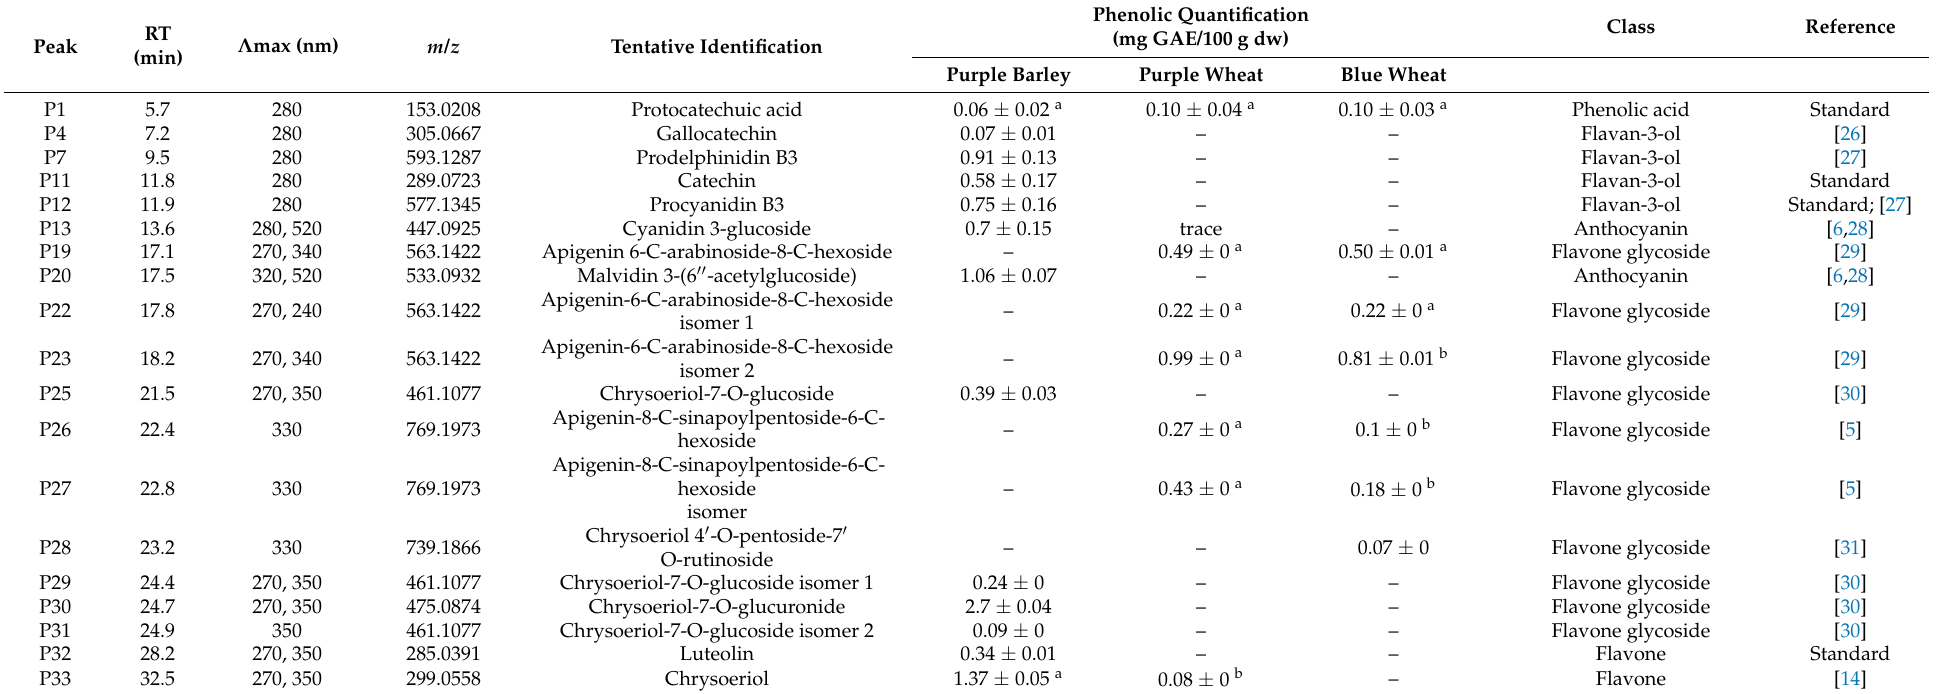
Table 1. Quantification (mg GAE/100 g dw) of barley and wheat polyphenols at 280